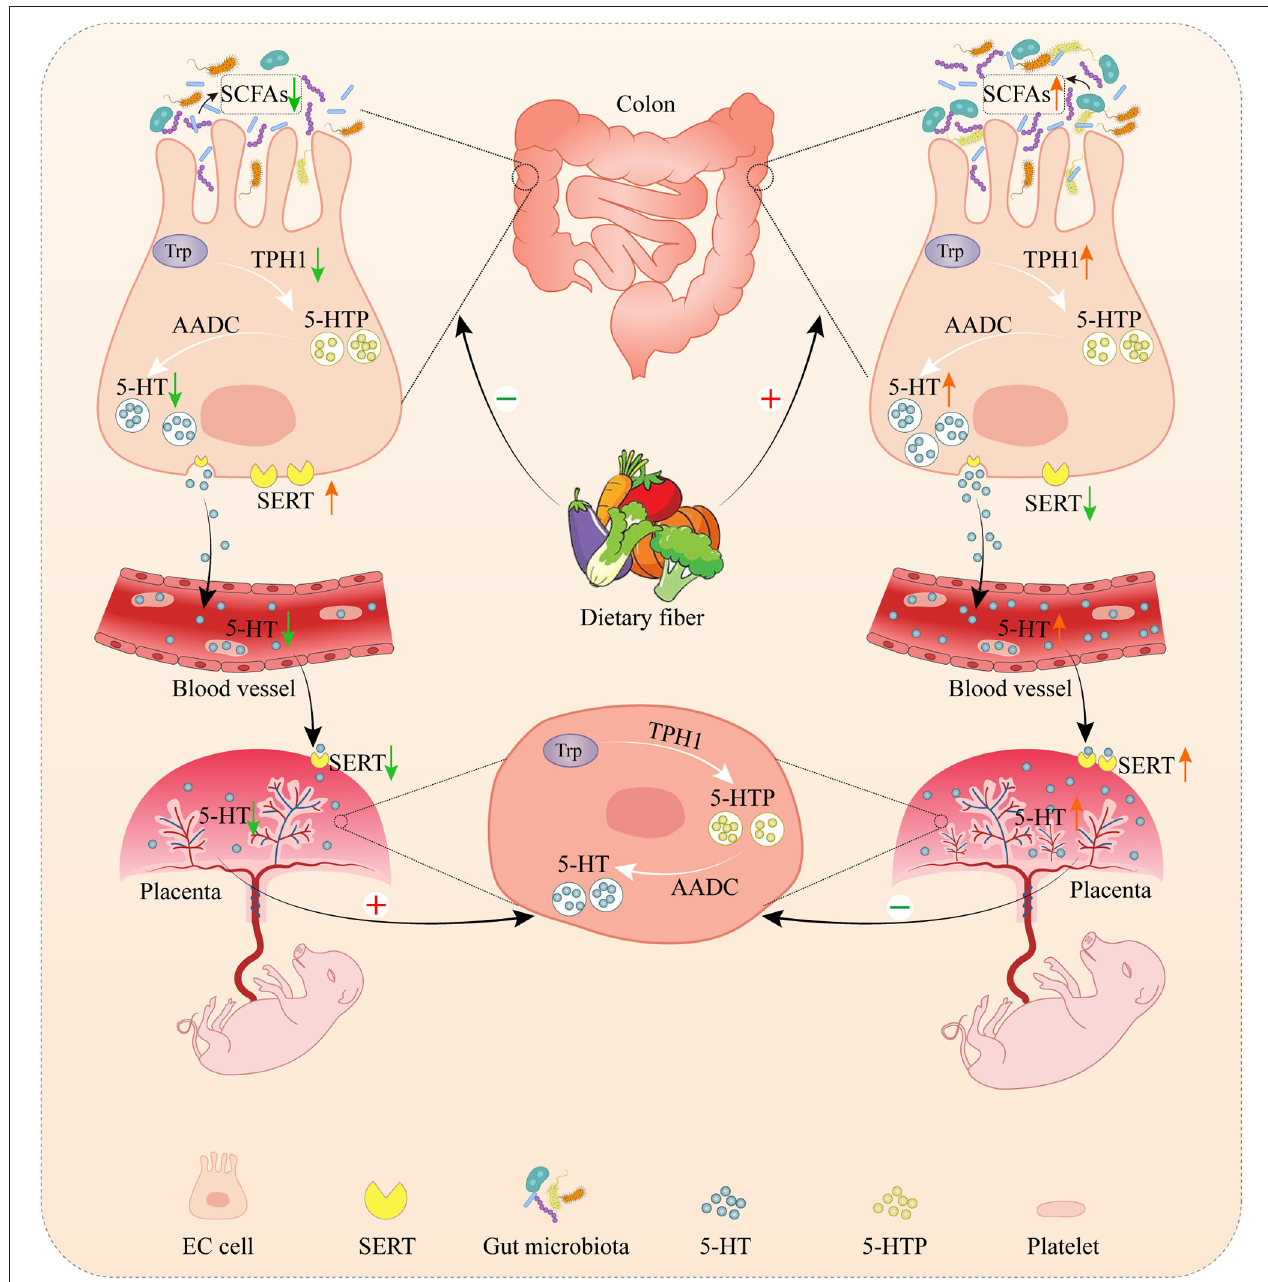
FIGURE 9 | The role of dietary fiber in regulating serotonin signaling pathway and placental and fetal development in gestating sows. Serotonin, as known as 5-hydroxytryptamine (5-HT), is mainly produced in the gut by enterochromaffin cells (ECs). In the gut, tryptophan is first converted to 5-hydroxytroptophan (5-HTP) by tryptophan hydroxylase 1 (TPH1), and aromatic amino acid decarboxylase (AAAD) subsequently converts 5-HTP into serotonin. Gut-derived serotonin can be transported into platelets via serotonin transporter (SERT) which allows the distribution of gut-derived serotonin to peripheral tissues (including the placenta) to regulate diverse functions. The placenta was also capable of producing serotonin. Dietary fiber supplementation increased the colonic concentration by promoting serotonin synthesis in the colon by changing the microbial composition and short-chain fatty acids (SCFAs), leading to an increase in the concentration of maternal serotonin. Meanwhile, dietary fiber supplementation enhanced the serotonin transport from the mother to the placenta, and then increased the placental serotonin concentration, accompanied by the promotion of fetal and placental development. The deprivation of dietary fiber inhibited the serotonin synthesis in the colon and the serotonin transport from the mother to the placenta, leading to the decrease of serotonin in the placenta. However, the deprivation of dietary fiber increased the serotonin transport from the colon to the blood and the serotonin synthesis in the placenta, which might be a compensatory response by the body to compensate for the deficient serotonin in the mother and